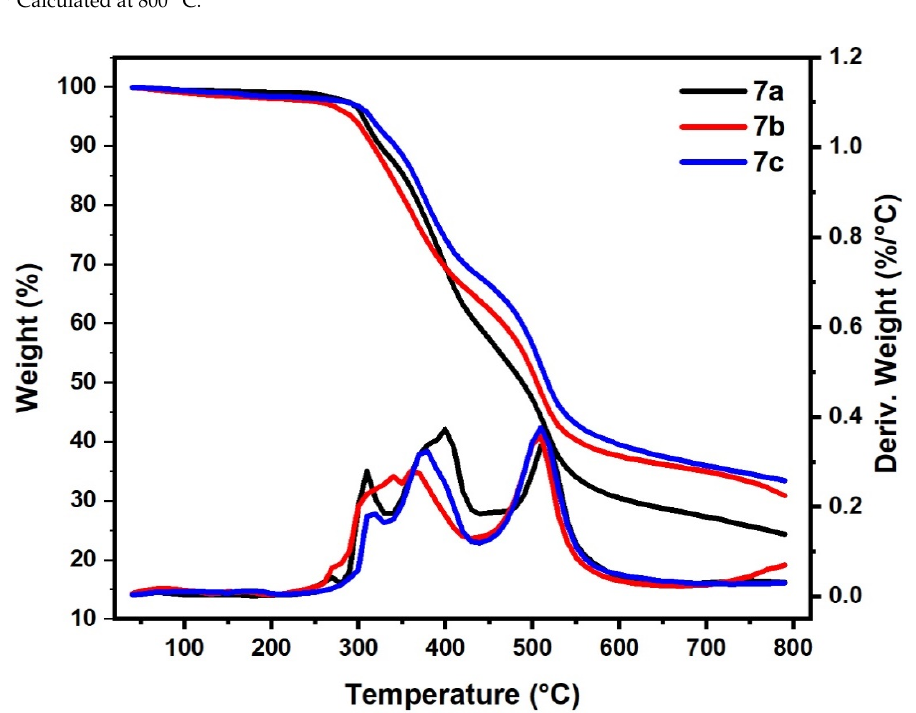
Figure 7. Thermogravimetric analysis of samples (7a-c).